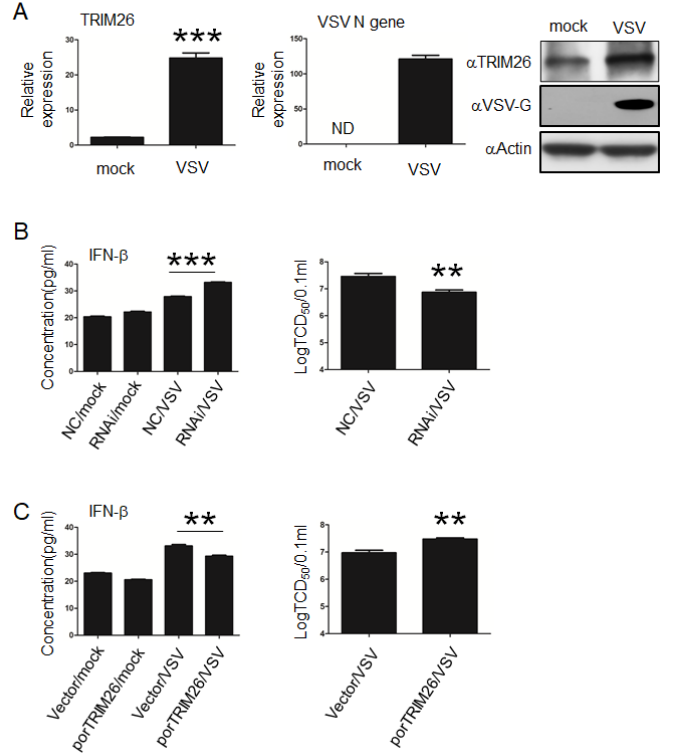
Figure 4. Effect of porTRIM26 on IFN- β expression and vesicular stomatitis virus (VSV) infection in PIEC cells. ( A ) PIEC cells were infected with VSV at a multiplicity of infection (MOI) of 1 for 24 h. The porTRIM26 mRNA and protein level was measured by RT-qPCR and Western blotting, respectively. ( B ) PIEC cells were transfected with porTRIM26 siRNA or NC siRNA. After 72 h, the cells were mock infected or infected with VSV at a MOI of 1. Supernatants were collected at 24 h post infection (hpi) for tissue culture infective dose (TCID 50 ) assay. ( C ) PIEC cells were transfected with plasmid encoding porTRIM26 or empty vector for 24 h and then infected with VSV at an MOI of 1. Supernatants were collected at 24 hpi for either a TCID 50 assay or ELISA. Data are mean ± SEM pooled from one independent experiment; n ≥ 3 for each of the analyzed parameters. ND, no detected. **, p < 0.01; ***, p < 0.001 in comparison: mock-infected vs. VSV-infected group ( A ); NC-treated vs. siRNA-treated groups after VSV infection ( B ); empty-vector-transfected vs. pFlag-pTRIM26-transfected after VSV infection ( C